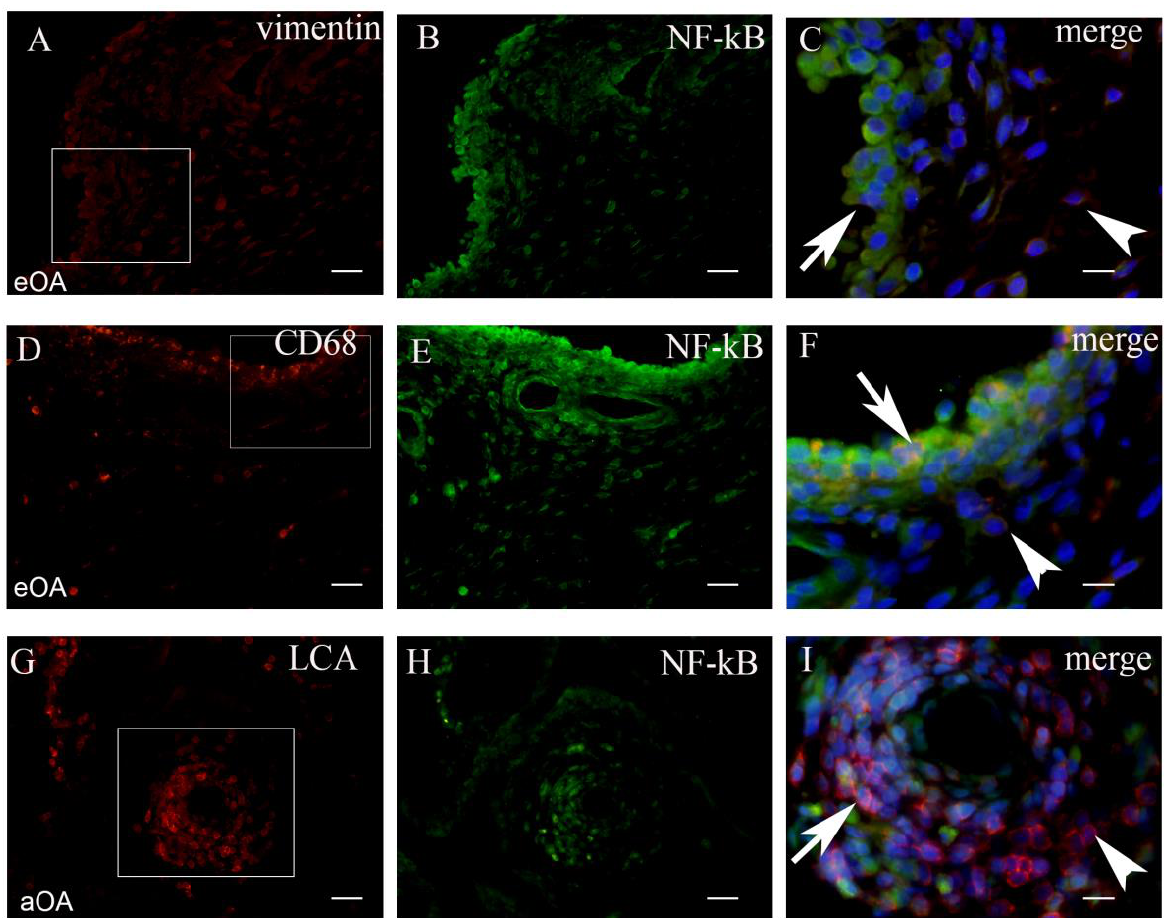
Figure 3. The synovial membrane of patients with early OA (eOA) ( A – C ). Vimentin positive (red) fibroblasts in the intima and subintima (frame), NF-kB positive cells (green) in the synovial intima and subintima ( B ). The merge of DAPI (blue) nuclear stain+vimentin+NF-kB (magnification of the frame in panel ( A )) show numerous fibroblasts in the intima co-localized with NF-kB and vimentin (arrow), while the subintima displays vimentin positive fibroblasts (arrowhead) ( C ). The synovial membrane of patients with early OA (eOA) ( D – F ). CD68 positive (red) macrophages in the intima and subintima (frame). NF-kB positive cells (green) in the synovial intima and subintima ( E ). The merge of DAPI (blue)+CD68+NF-kB (magnification of the frame in panel ( D )) show numerous macrophages in the intima co-localized with NF-kB and CD68 (arrow), while the subintima displayed CD68 positive macrophages(arrowhead) ( F ). The synovial membrane of patients with advanced OA (aOA) ( G – I ). LCA positive (red) lymphocytes in the intima, subintima, and lymph nodule (frame). NF-kB positive cells (green) in the synovial intima and subintima ( H ). The merge of DAPI (blue)+LCA+NF-kB (magnification of the frame in panel ( G )) show numerous lymphocytes in the lymph nodule co-localized with NF-kB and LCA (arrow), while some lymphocytes displayed only LCA (arrowhead) ( I ). Magnification ×40 (first two columns), scale bar 25 µm and ×100 (last column), scale bar 10 µm.